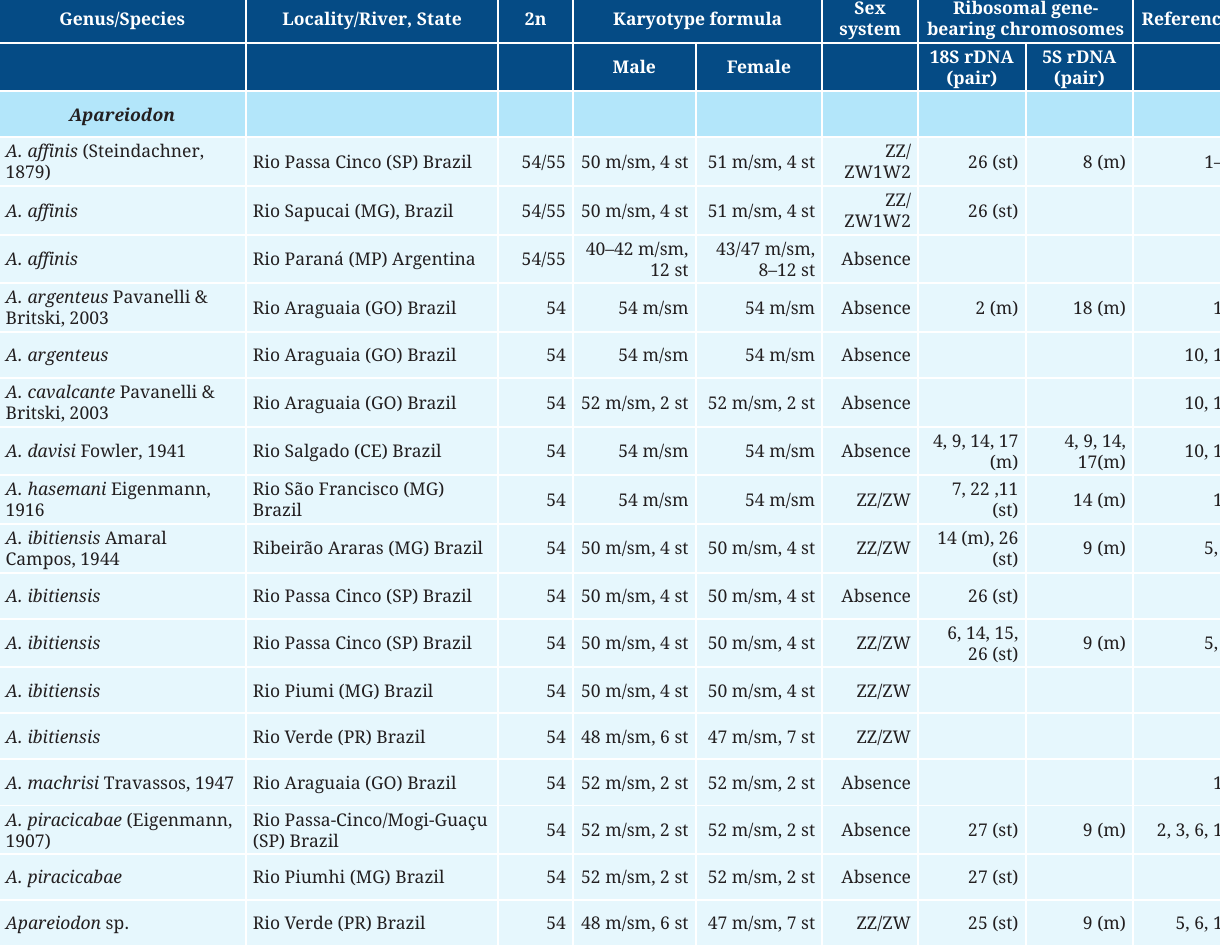
TABLE 1 | Cytogenetic characteristics in Parodontidae. 1. Moreira Filho et al. , 1980; 2. Moreira Filho et al ., 1985; 3. Jesus et al. , 1999; 4. Jorge, Moreira-Filho, 2000; 5. Bellafronte et al. , 2009; 6. Bellafronte et al. , 2011; 7. Schemberger et al. , 2011; 8. Leite, Maistro, 2004; 9. Calgaro et al. , 2004; 10. Traldi et al. , 2016; 11. Traldi et al. , 2019; 12. Bellafronte et al. , 2012; 13. Moreira-Filho et al. , 1984; 14. Vicari et al. , 2006; 15. Santos et al. , 2019; 16. Rosa et al. , 2006; 17. Moreira-Filho et al. , 1993; 18. Centofante et al ., 2002; 19. Bellafronte et al. , 2005; 20. Paula et al. , 2017. Genus/Species Locality/River, State 2n Karyotype formula